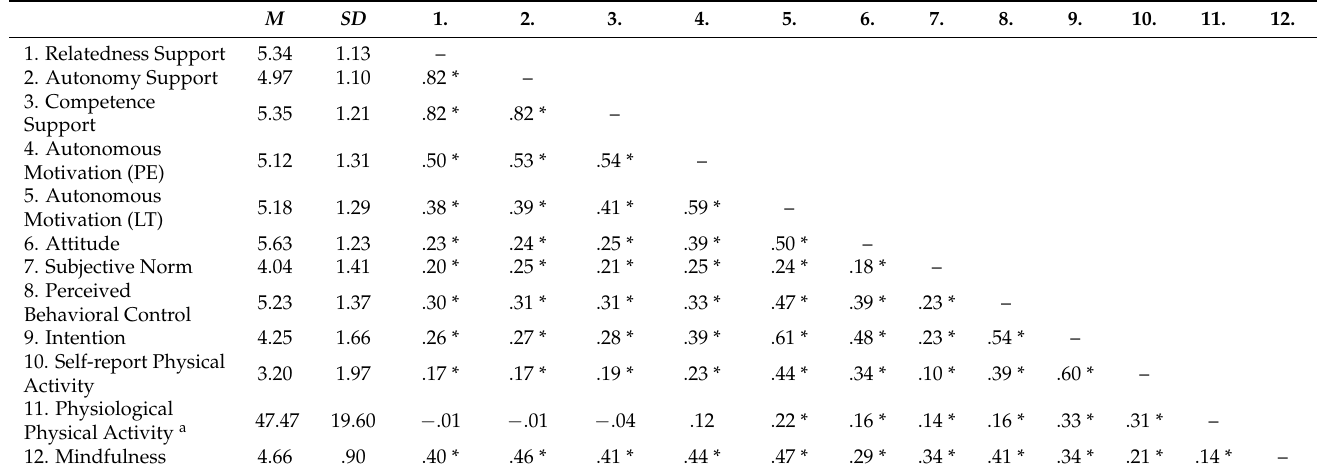
Table 1. Descriptive statistics and correlation matrix of the study